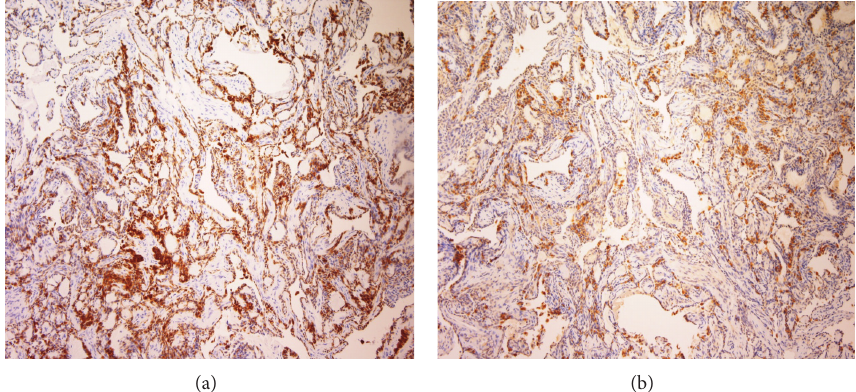
Figure 5: Immunohistochemical study of ELST. The tumor cells showed positive reactivity with pan-cytokeratin MNF116 (a) and chromogranin A (b) (immunostaining,